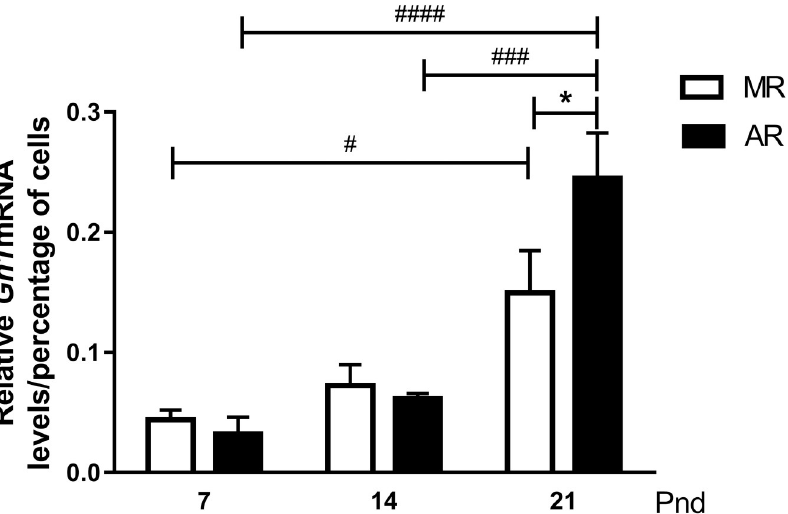
Fig 4. Gh mRNA in pituitaries from MR and AR pups at pnd7, pnd14 and pnd21. Total RNA was extracted from homogenates of pituitaries of pnd7 (pools of 8 pups), pnd14 (pools of 6 pups) and pnd21 (pools of 5 pups), n = 3 different extractions. Gh mRNA levels in pups were normalized according to male adult levels and fitted by the percent of somatotroph cells present in the pituitary at each age. Differences in pituitary content in MR and AR pups at the three ages studied were compared by two way-ANOVA, followed by a Tukey´s multiple comparisons posttest for differences between ages in both groups, # P < 0.05, ### P < 0.001, #### P < 0.0001, and by Sidak´s multiple comparisons posttest for differences between MR and AR groups, � P <